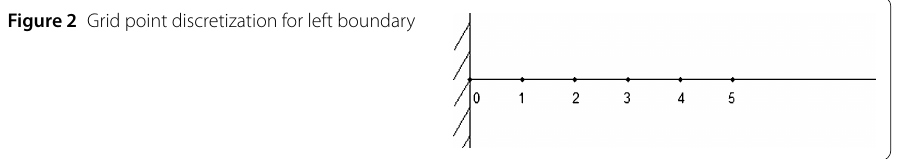
Figure 2 Grid point discretization for left